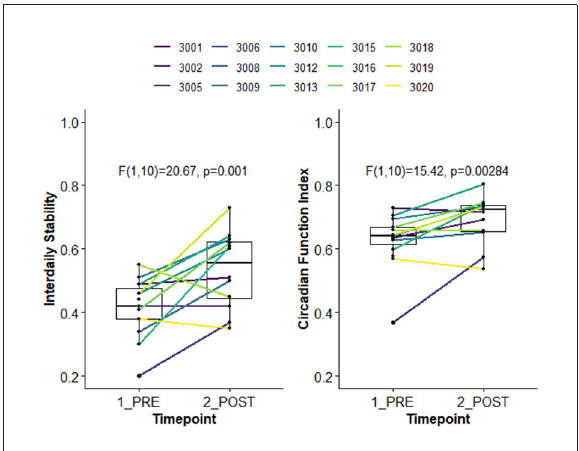
FIGURE3 Pre-to-post improvement in 24-h rest activity rhythms in open pilot study.